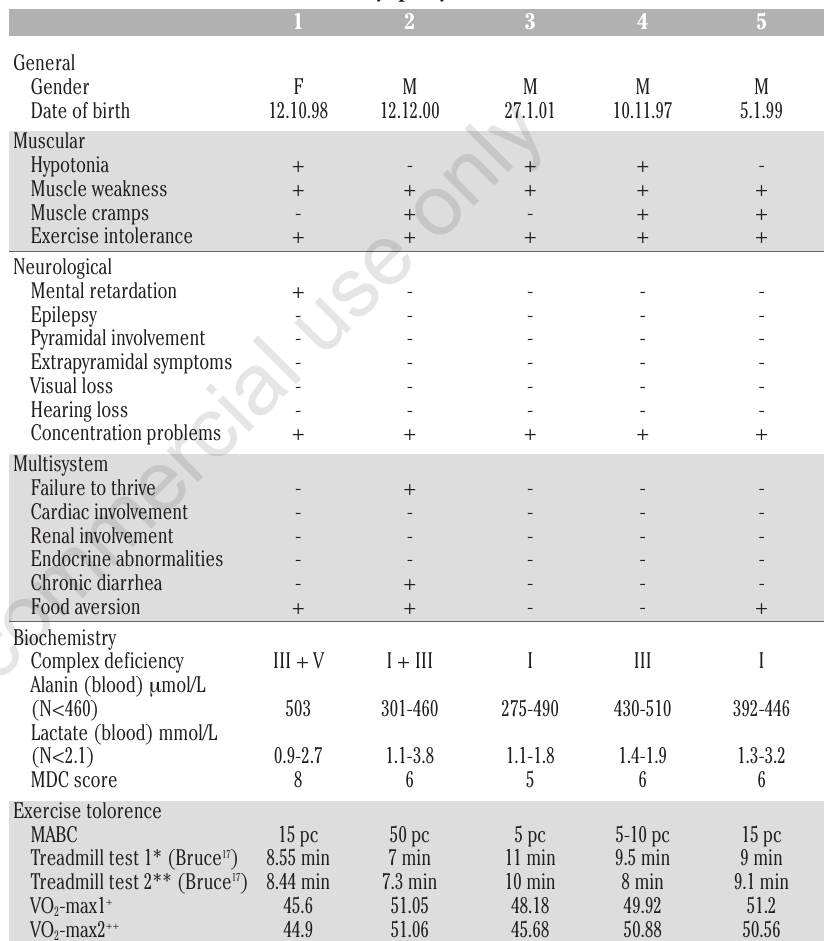
Table 1. Parameters in mitochondrial